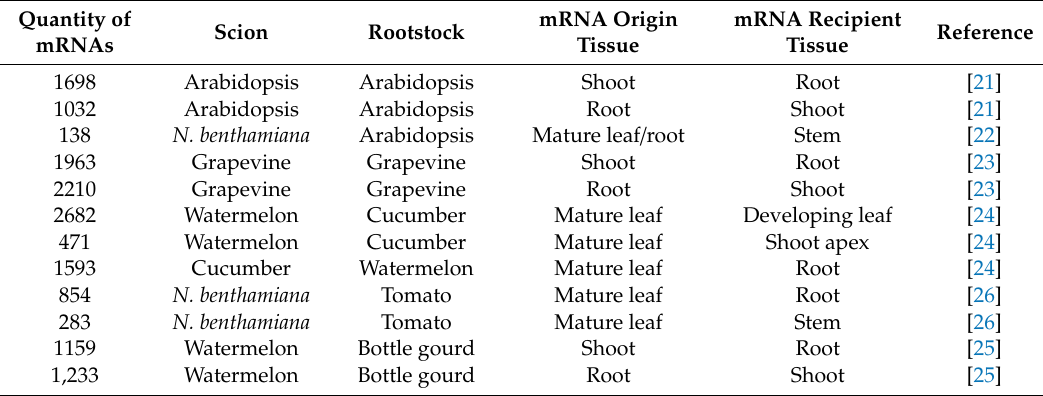
Table 1. Overview of the mobile mRNA identified in multiple